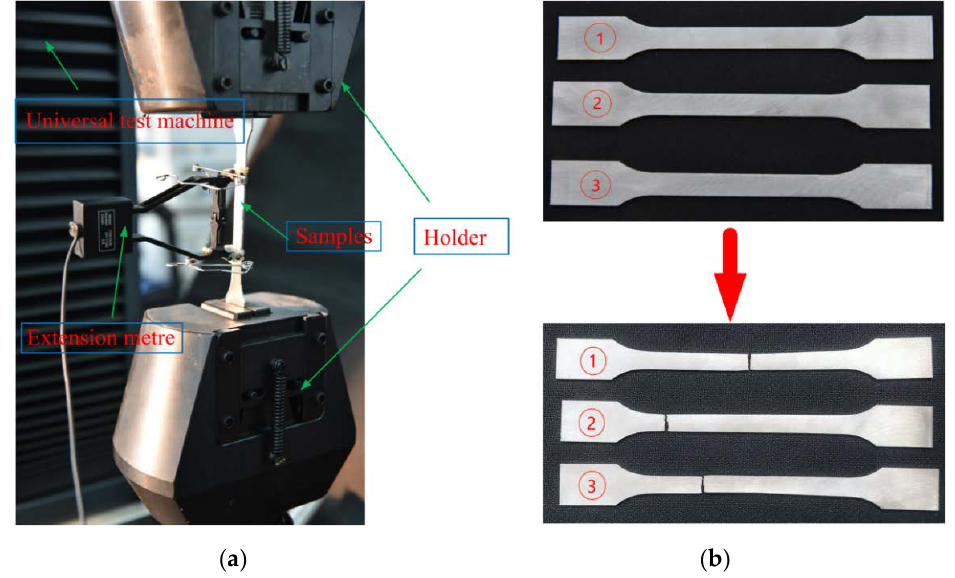
Figure 8. Single-axis tensile test of 316 L sample: ( a ) test device; ( b ) samples.